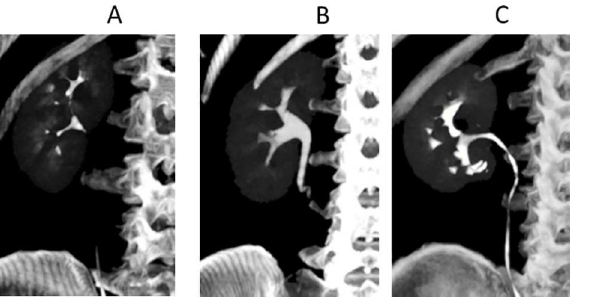
Fig 1. Examples of the evaluation of opacification scores of the proximal ureter on maximum intensity projection (MIP) images. A, A 5-minutedelay scored as 1 ( < 50%);B, A 5-minute delay scored as 2 (51–99%);and C, A 5-minutedelay scored as 3